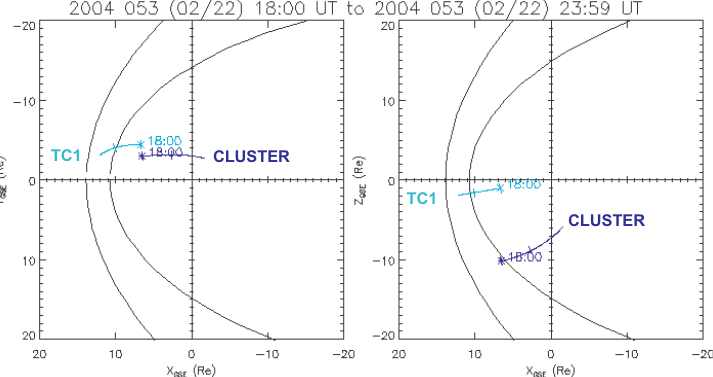
Fig. 10. Orbits of DSP TCI and Cluster for 22 February 2004 from 18:00 to 24:00 UT, including the period shown in Fig. 9. Asterisks correspond to 18:00 UT and the bars to 21:00 UT. Their orbits are in the same meridian plane, but the latitude is different at the time of the magnetopause